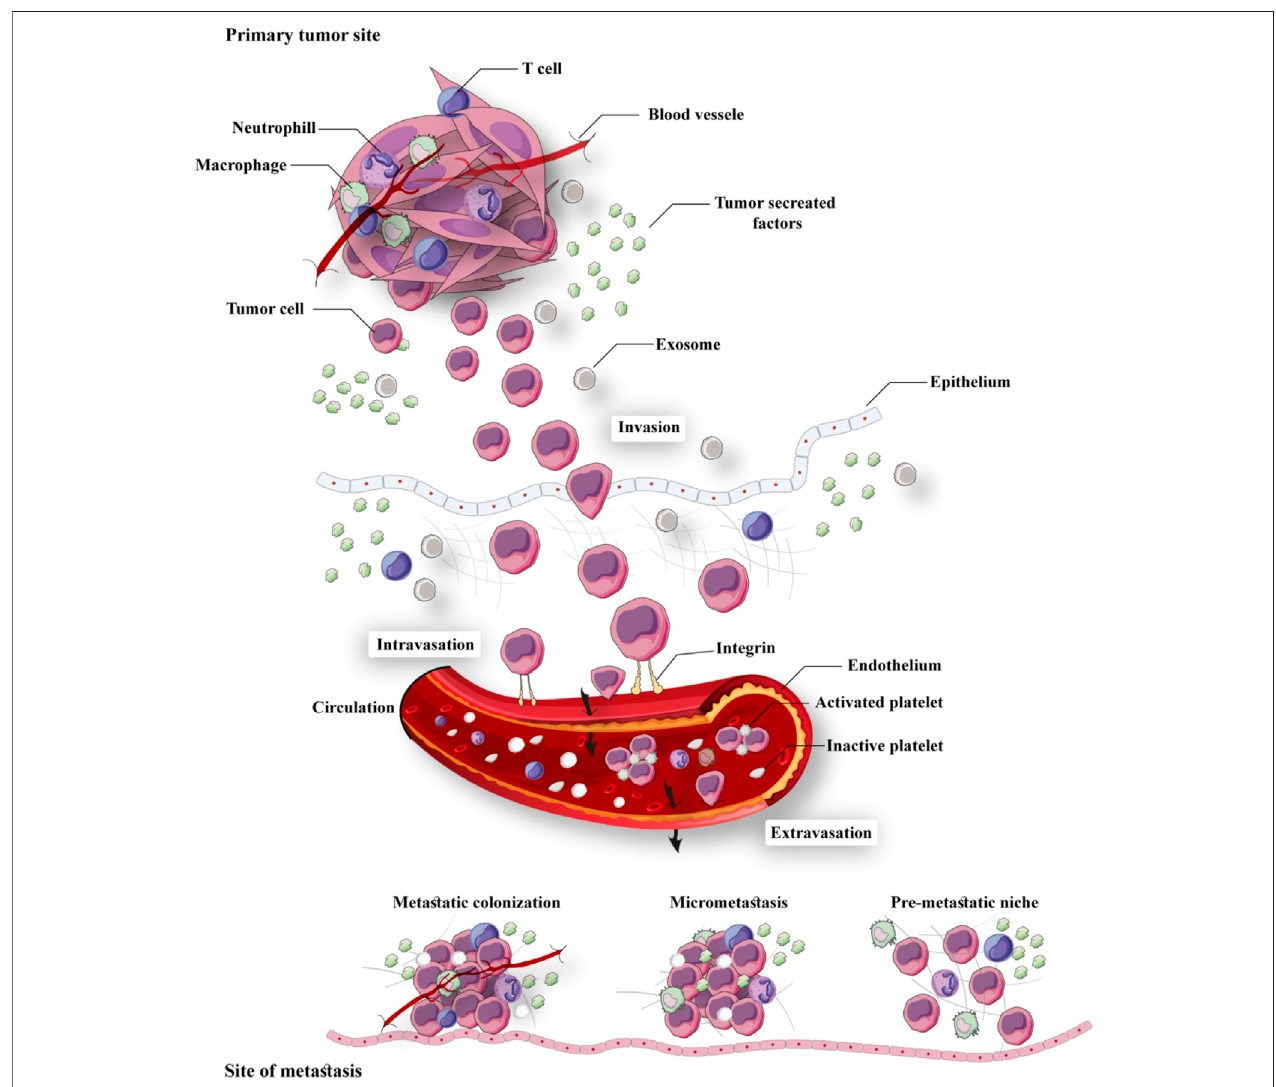
FIGURE 1 | Summary of the metastatic cascade: The metastatic cascade is subdivided into multiple main steps, including invasion, intravasation, circulation, extravasation, and colonization.